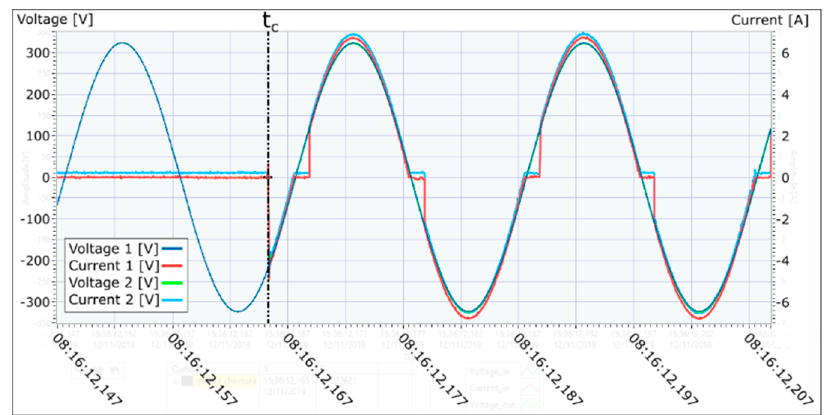
Figure 10. Instant ( t c ) at which the arc was formed (using the Bourns 2049-12 surge arrester).